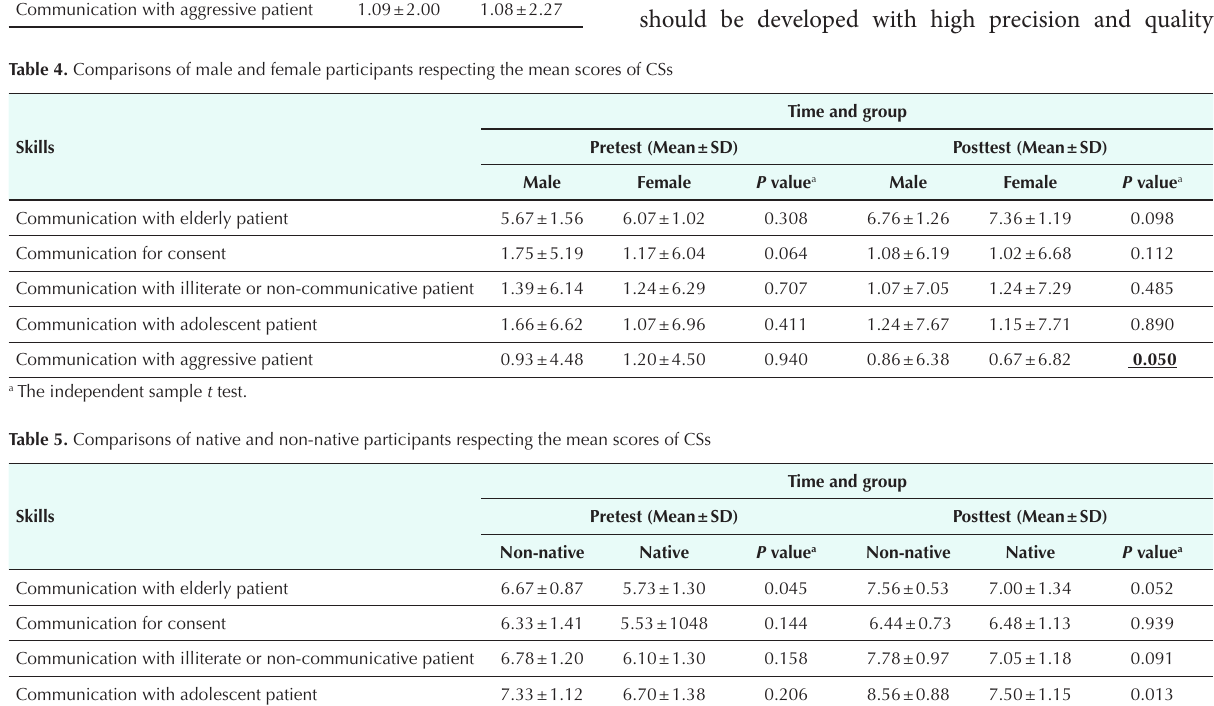
Communication with elderly